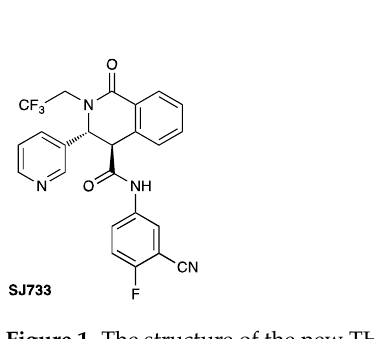
Figure 1. The structure of the new THIQ antimalarial SJ733.